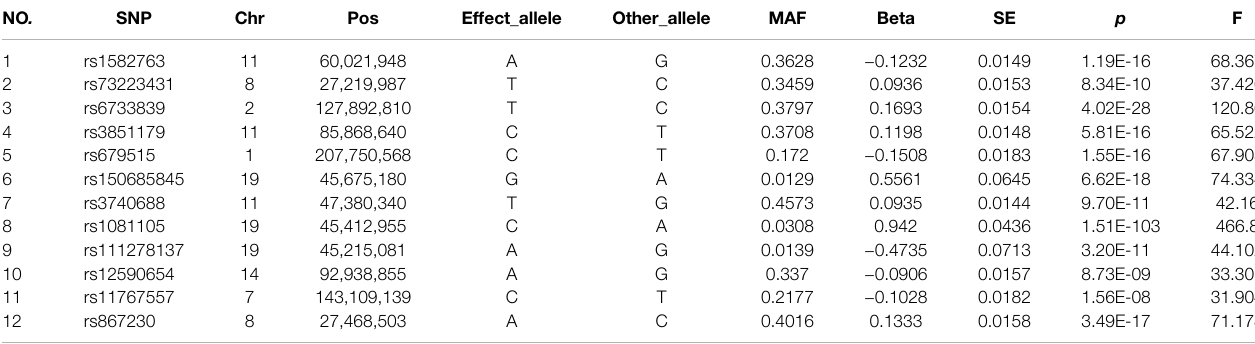
TABLE 1 | Detailed information of selected SNPs for MR analysis of the causal effect of AD on HF. NO .